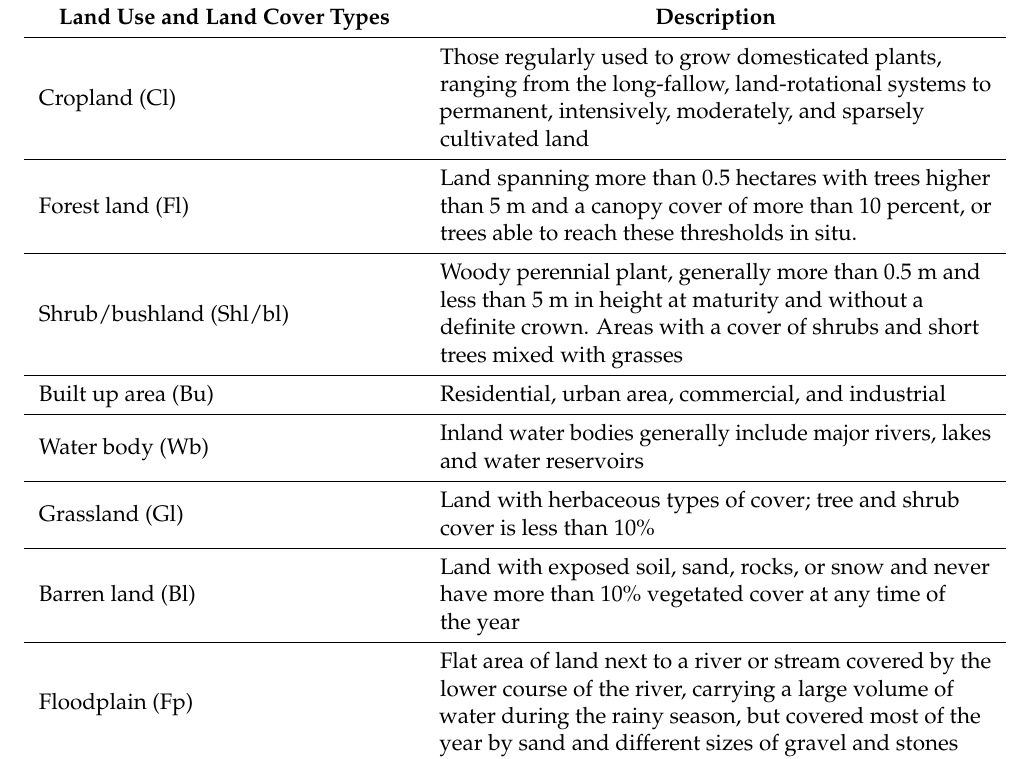
Table 3. Description of land use and land cover types in the study area [22].